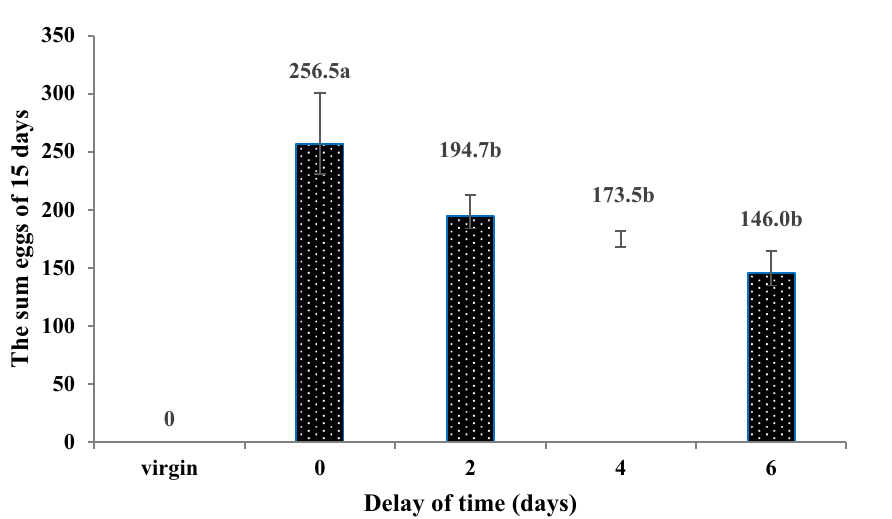
Figure 8. The number of eggs laid by females C. japonicus at different delayed mating. Data in the figure is mean ± standard error, different letters indicate significant differences in Duncan’s test, with a probability of